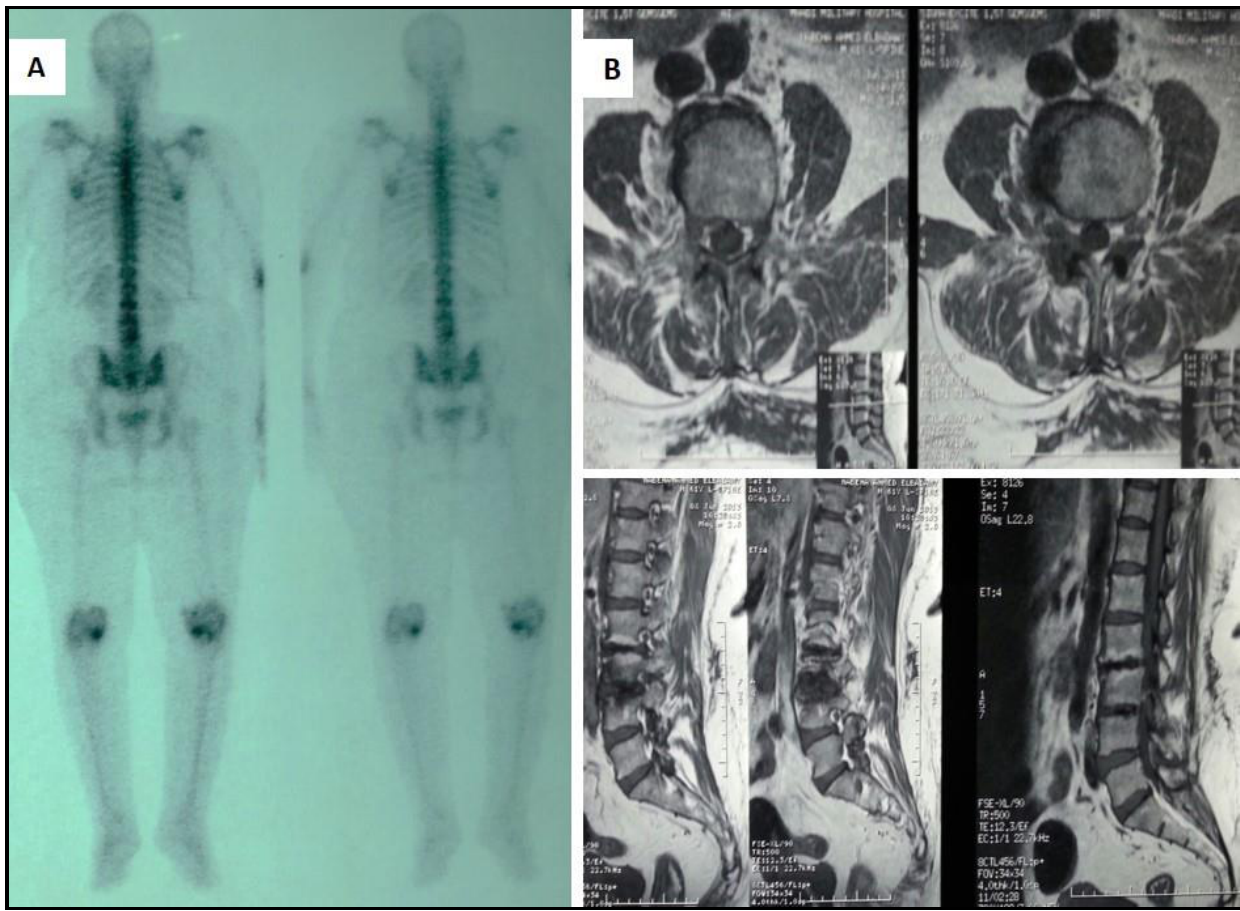
Figure 1 : 61 years old female with breast cancer, low back pain and a body mass index of 46. A : Bone scan showing enhanced tracer uptake in the mid and lower lumbar vertebra interpreted as degenerative changes. B : MRI confirmed these findings by showing spondylo-degenerative changes at L3-L4, L4-L5 lumbar vertebra with diffuse disc bulge at L3-L4 and